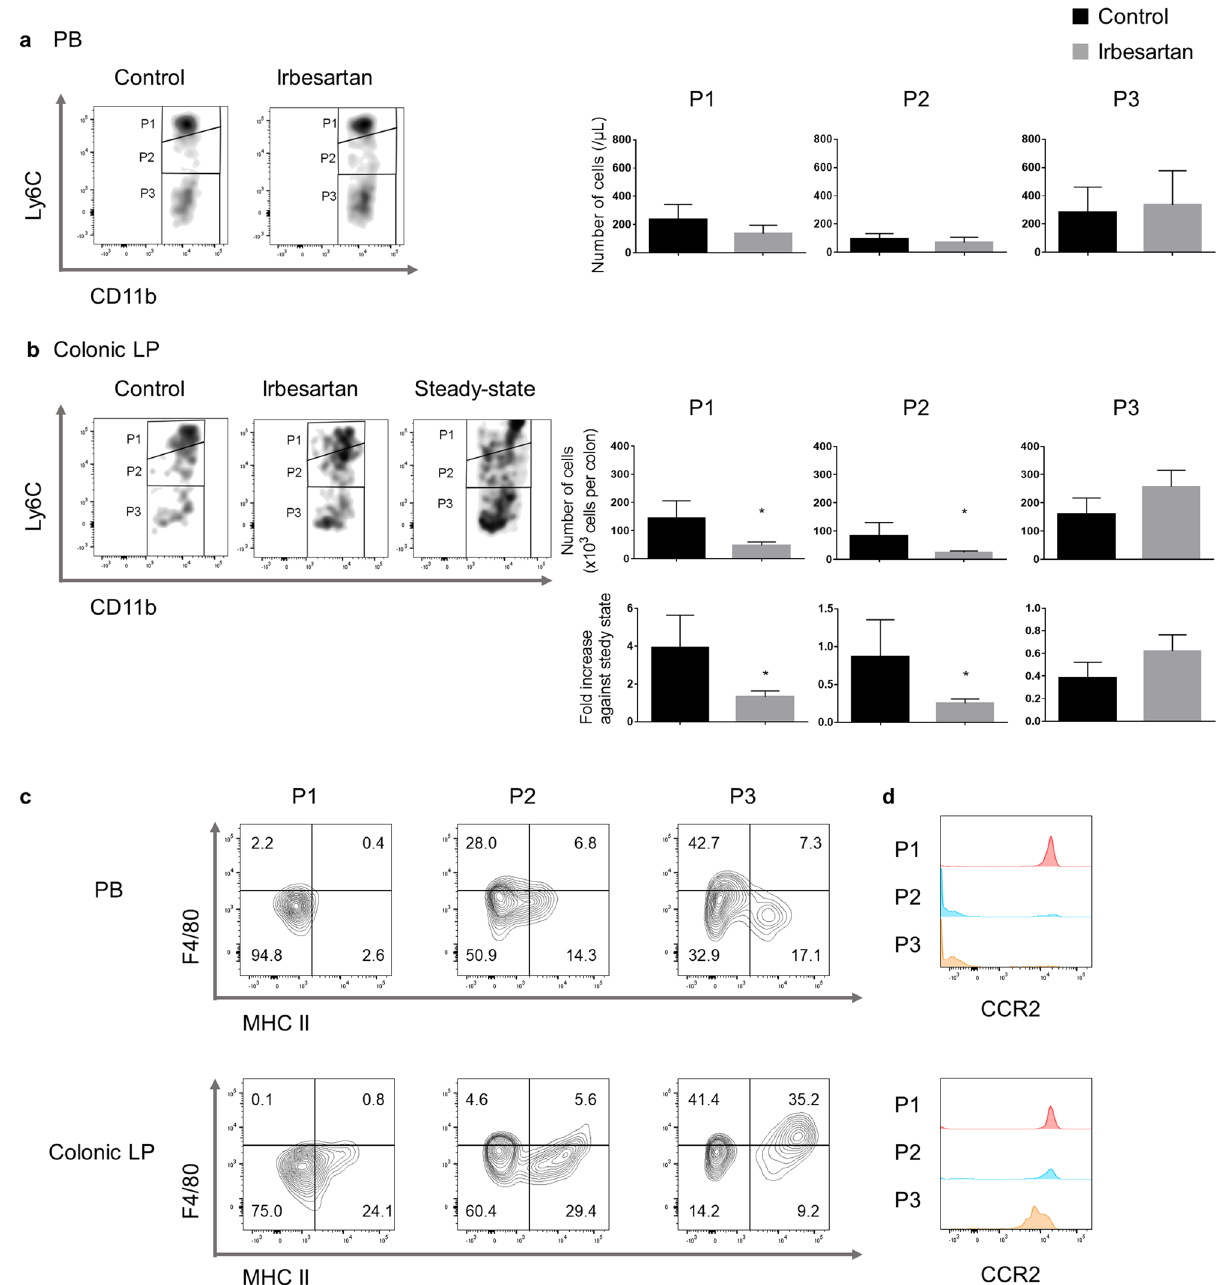
Figure 2. Monocyte-derived cell heterogeneity in the peripheral blood (PB) and colonic lamina propria (LP). ( a ) Flow cytometry representative dot plots of the PB of control and irbesartan-treated mice. Three different monocyte-derived cell fractions (P1, P2 and P3) were defined by the different expression of lymphocyte antigen 6C (Ly6C). The absolute cell numbers for each fraction in the PB of both mice groups are shown. ( b ) Flow cytometry representative dot plots of colonic LP of control, irbesartan-treated and steady-state mice. The absolute cell numbers for each fraction in the colonic LP of control and irbesartan-treated mice are shown in the upper row. The fold increase of each fraction compared to the value at steady state in the colonic LP from control and irbesartan-treated mice appears in the bottom row. Data are presented as mean ± SD (control mice, n = 4; irbesartan-treated mice, n = 4; steady-state mice, n = 4) ( c ) Representative flow cytometry analysis showing the F4/80 and MHC-II-expressing myeloid subpopulations in the three fractions obtained from the PB and colonic LP in control mice. ( d ) Fluorescence-activated cell sorting histograms showing CCR2 expression profiles in the three fractions obtained from the PB and colonic LP in control mice. *P < 0.05 versus control